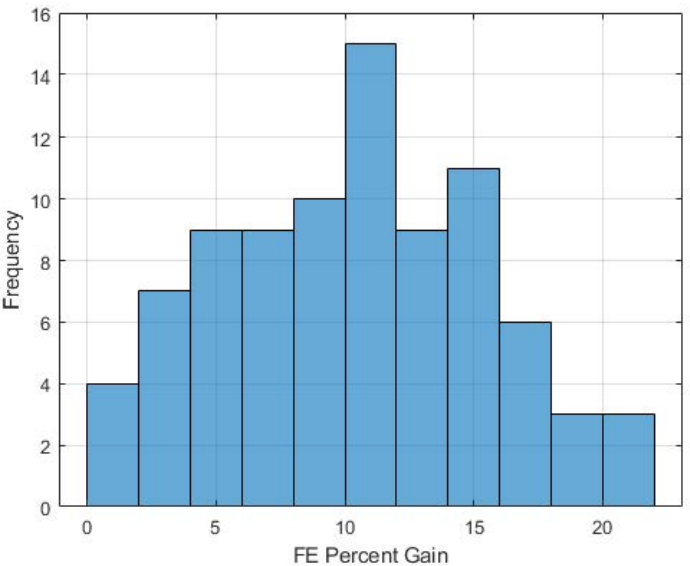
Figure 14. Fuel economy percent gain of DP-ECMS over